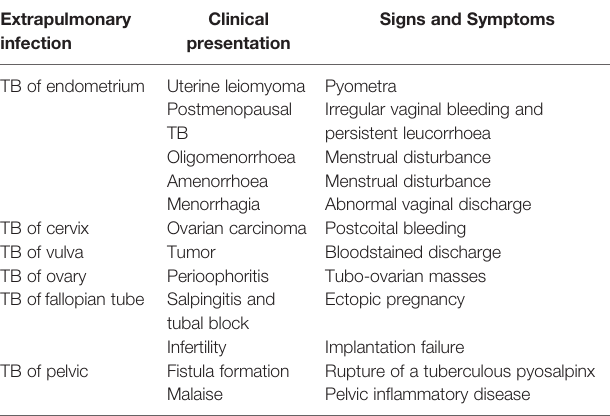
TABLE 2 | Various forms of clinical presentations of FGTB are shown along with signs and